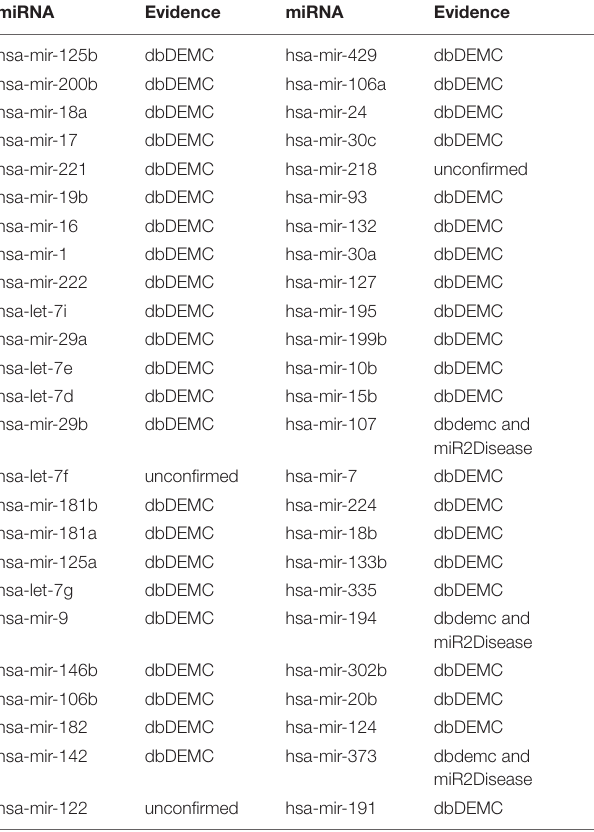
TABLE 1 | The implementation of BRWRMHMDA to prioritize candidate miRNAs for esophageal neoplasms based on experimentally confined miRNA–disease associations collected from HMDD v2.0 and 47 of the first 50 predicted miRNAs were confirmed.